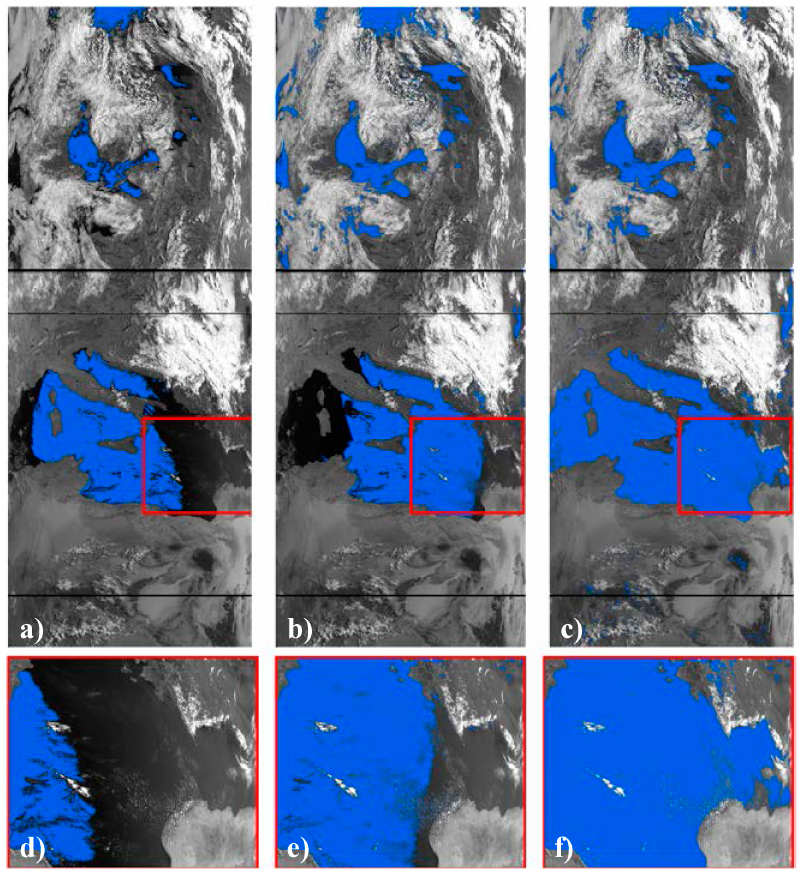
Figure 7. Water body classification based on single dynamic threshold ( a ); local dynamic threshold ( b ); and the minimum curvature of the dynamic local threshold ( c ); Details ( d – f ) show the result for the eastern Mediterranean. The blue area represents the area classified as water by the respective method.